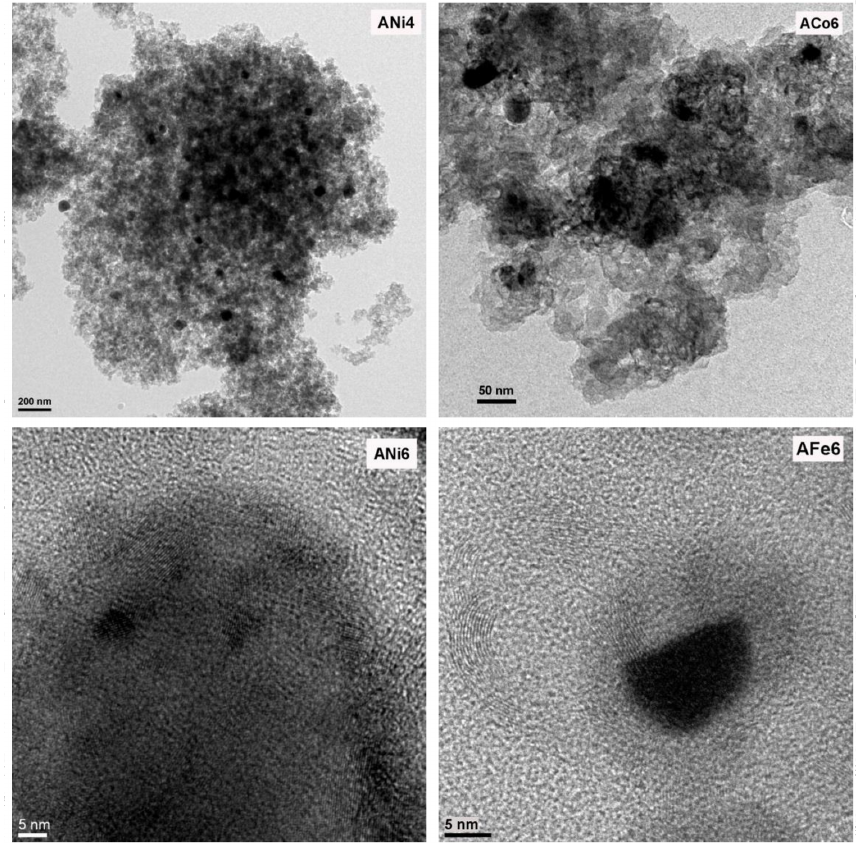
Figure 2. HRTEM images of the samples ANi4, ACo6, ANi6 and